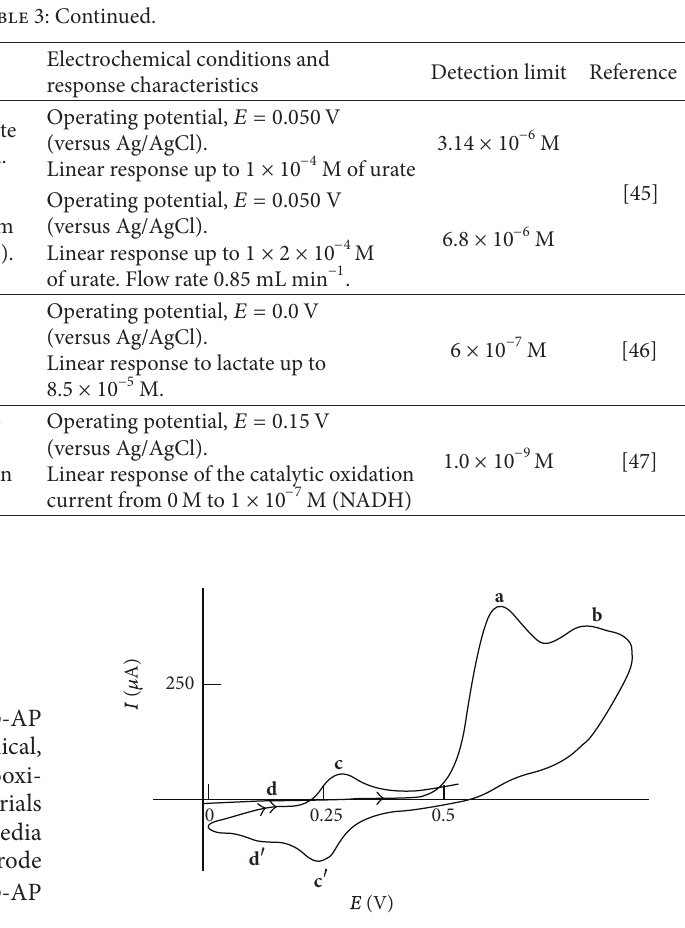
F 1: Cyclic voltammogram of a Pt electrode contacting a